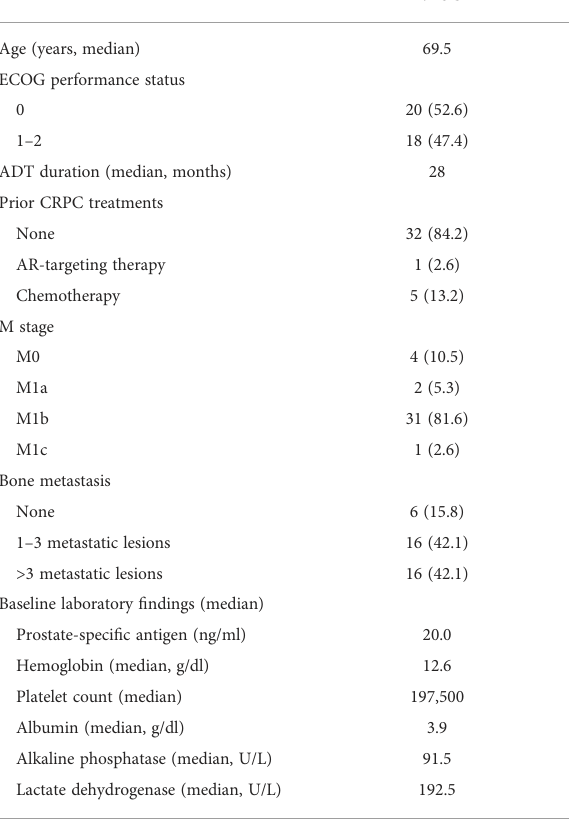
TABLE 1 Baseline demographic and clinical characteristics of patients with CRPC starting AR-targeting